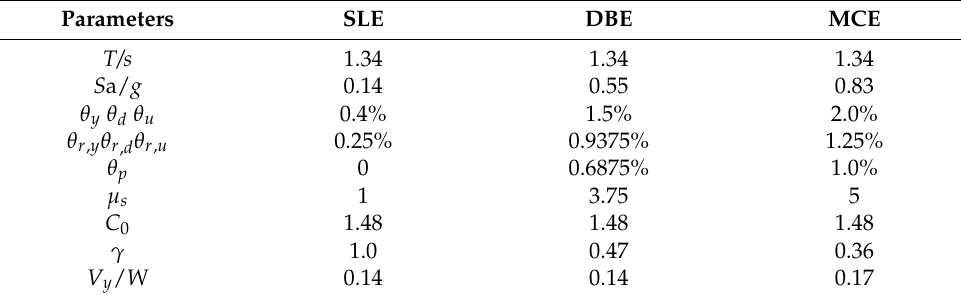
Figure 15. Fitting relationship between inter-story and roof drift ratios. Table 2. Design parameters in the design method.